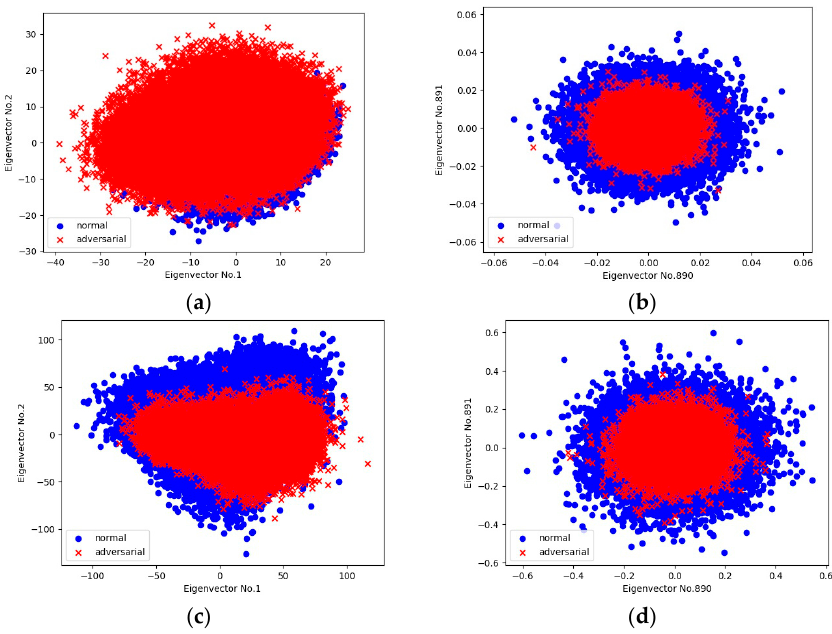
Figure 6. Scatter plots of PCA projection of activations at the first fully connected layer onto specific eigenvectors. Blue area indicates normal examples and red area indicates adversarial ones: in the shadow classifier, ( a ) projection onto the 1st and 2nd eigenvectors; ( b ) projection onto the 890th and 891st eigenvectors; in the target classifier, ( c ) projection onto the 1st and 2nd eigenvectors; ( d ) projection onto the 890th and 891st eigenvectors.